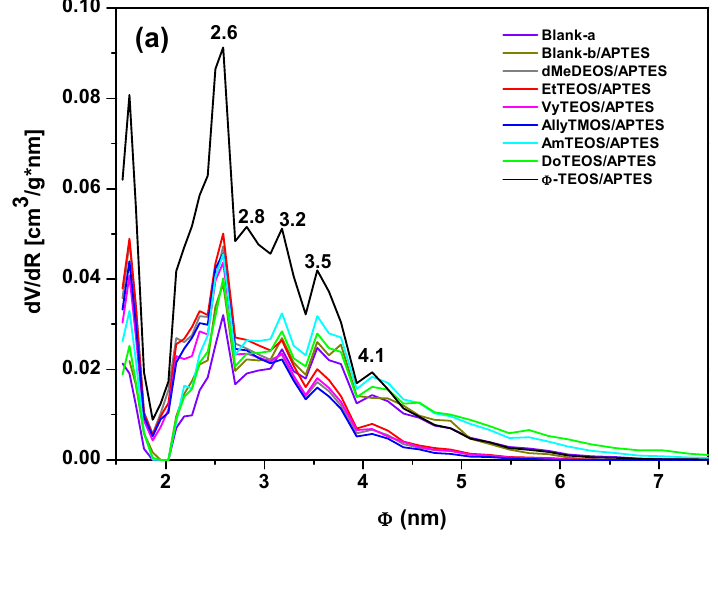
Figure 7. Pore-size distribution (PSD) calculated by assuming spherical pore cavities, from adsorption isotherms of organo-modified silica xerogel networks with the N 2 T( p -COOH)PP species covalently bonded to the pore walls through the linking action of H 2 ( a ) APTES or ( b )